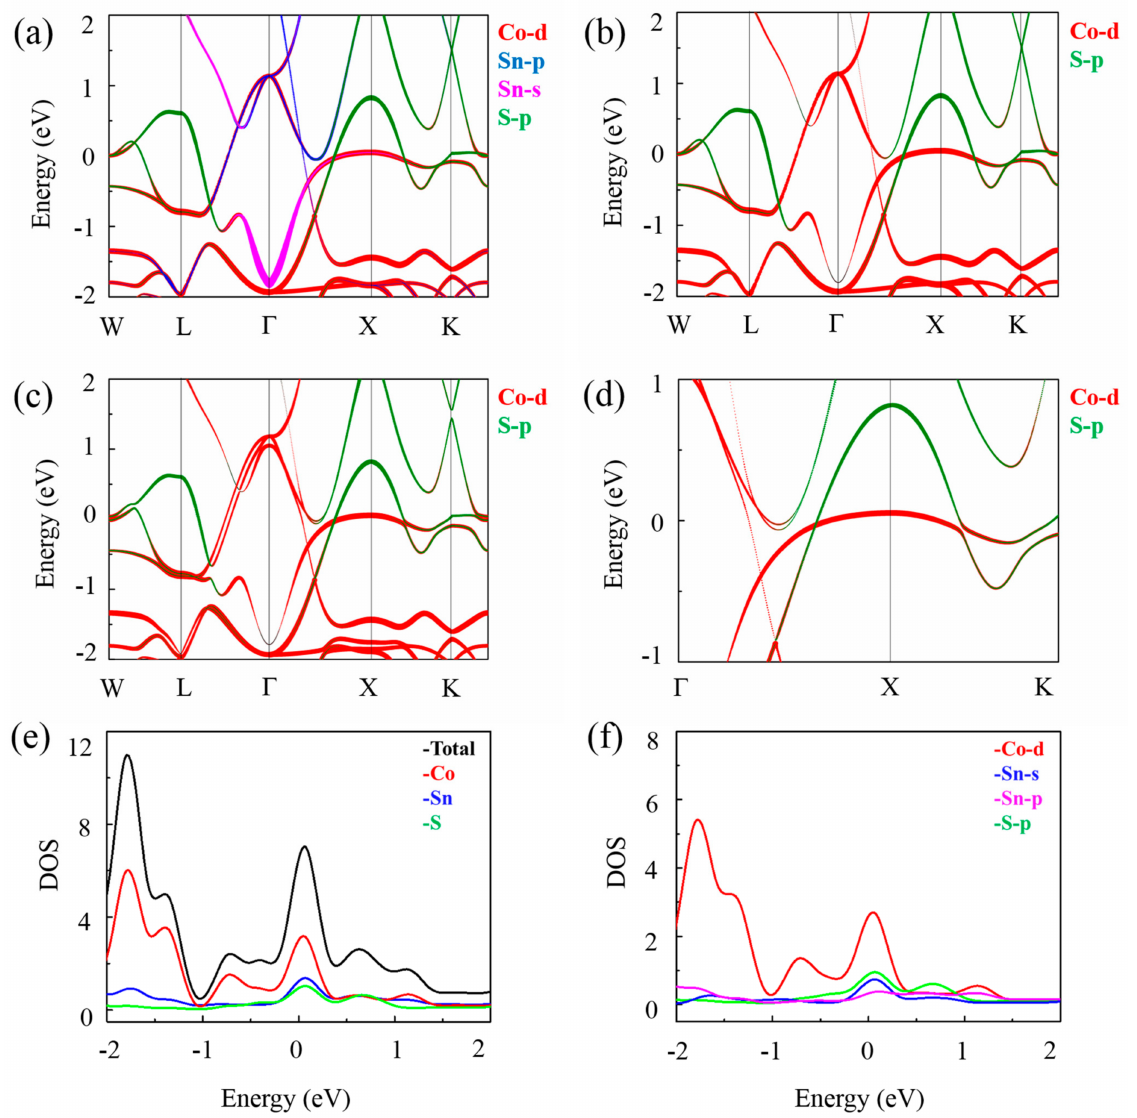
Figure 4. ( a , b ) The orbital-projected band structure of Sn 2 CoS without SOC. ( c , d ) The orbital-projected band structure of Sn 2 CoS with SOC. ( e ) The density of states (DOS) of Sn atom, Co atom, and S atom. ( f ) The DOS of Co- d , Sn- s , Sn- p, and S- p